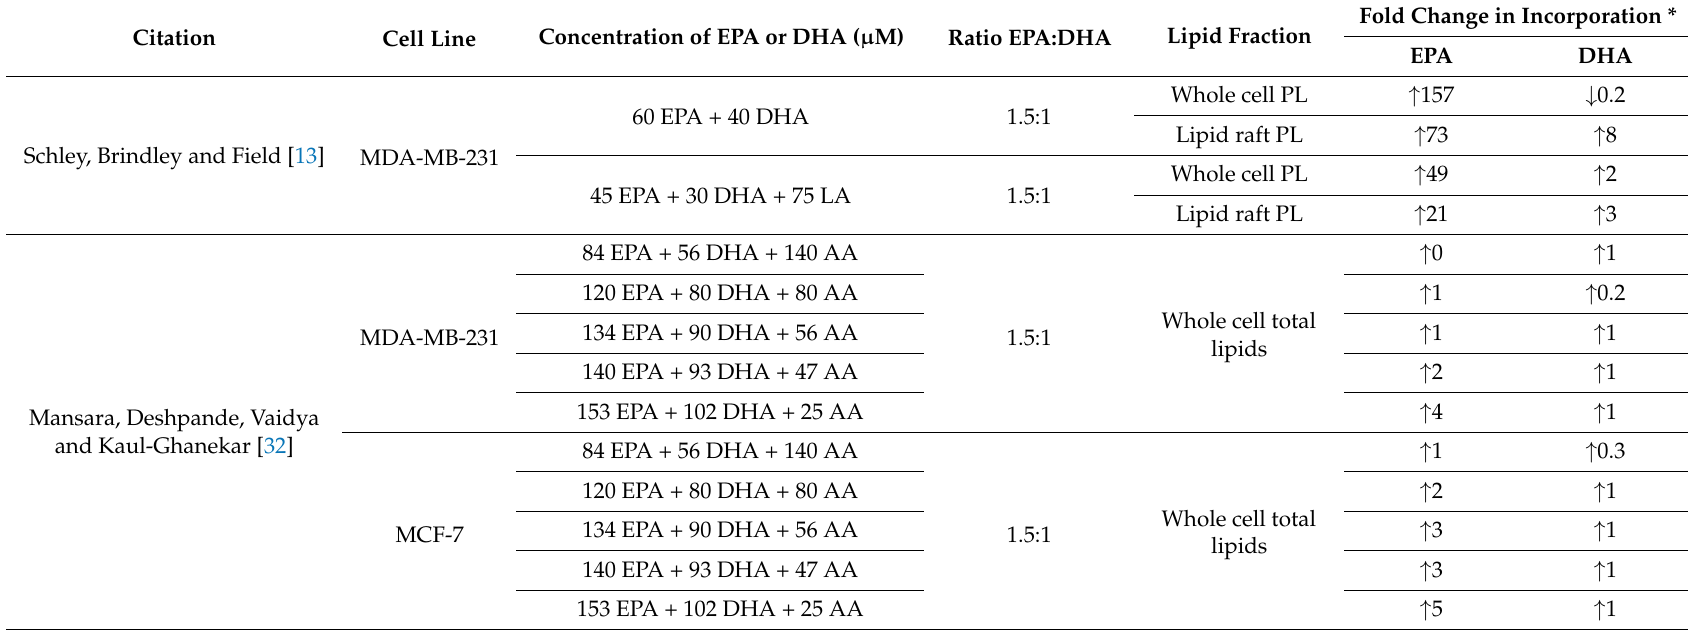
Table 1. Incorporation of EPA and DHA measured in the plasma membrane with EPA:DHA mixtures in human BC cell